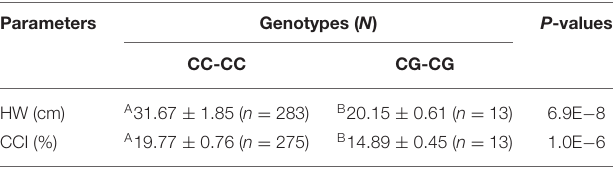
TABLE 8 | Least squares mean and standard error for growth parameters of different combination genotypes of the SNPs P27R and A85G within the GDF9 gene in Shaanbei white cashmere (SBWC)